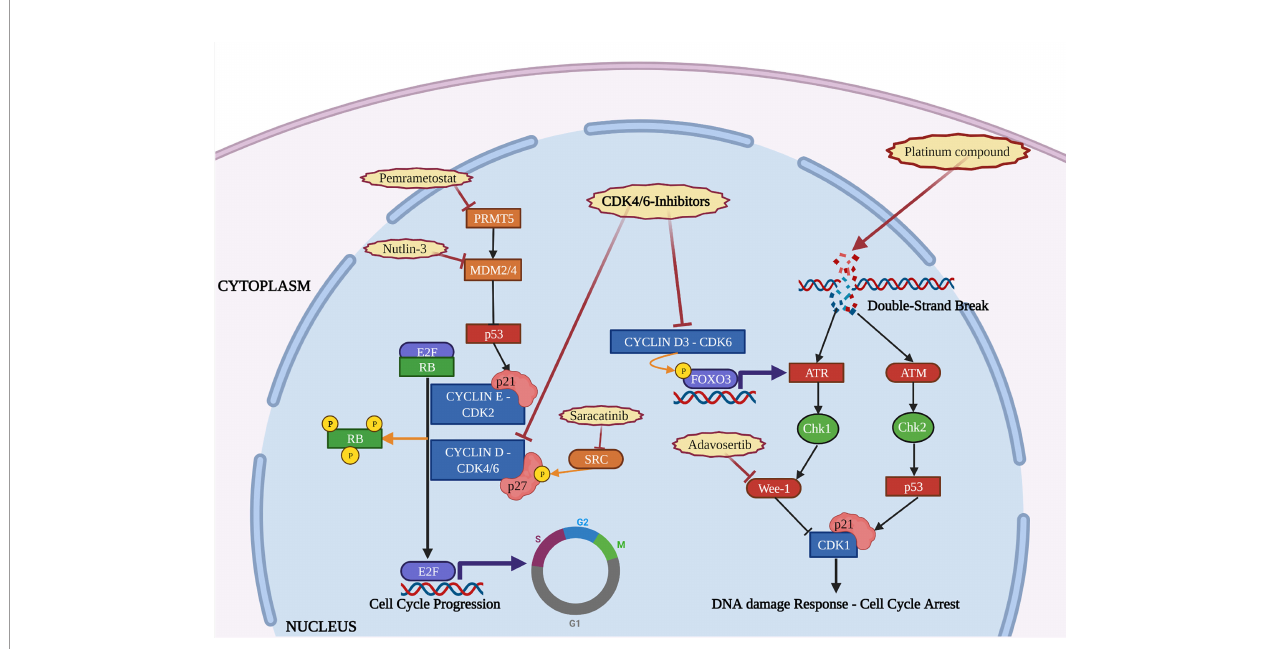
FIGURE 2 | The fi gure depicts the interactions occurring in the cell nucleus between the activity of CDK4/6-i, DNA damage repair and other molecular pathways. Mechanisms of resistance to CDK4/6-i (orange) and therapeutic strategies to overcome them (red) are reported. Created with